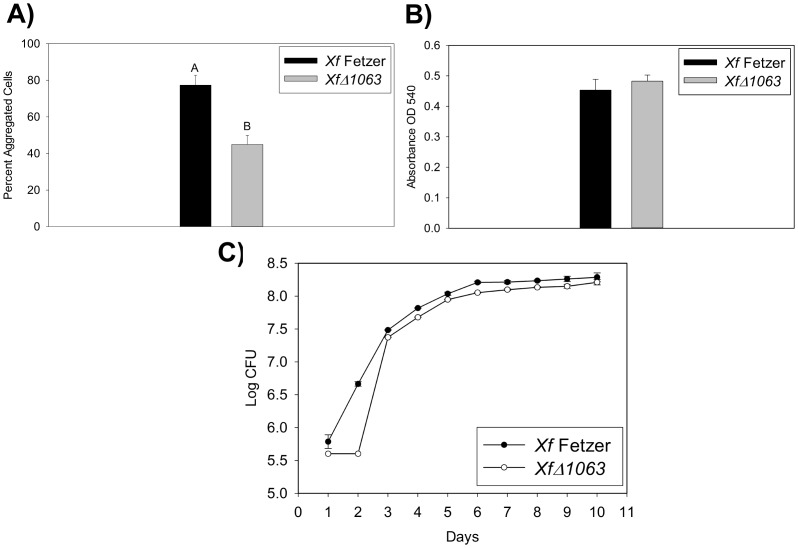
Evaluation of biofilm formation, cell aggregation and cell growth in XfΔ1063 mutants.A) Comparison of cell aggregation by wild-type Xf Fetzer, Xf Δ1063 mutant after 10 days growth in static liquid culture. Values shown are mean of 10 samples +/− standard error. The assay was repeated twice and data shown is representative of both assays. B) Comparison of biofilm formation by wild-type Xf Fetzer and Xf Δ1063 mutant after 10 days growth in static liquid culture. Values shown are mean of 10 samples +/− standard error. The assay was repeated twice and data shown is representative of both assays. C) Comparison of cell growth by wild-type Xf Fetzer and Xf Δ1063 mutant over 10 days growth in liquid culture with shaking at 100 rpm. Values shown are the mean of 10 samples +/− standard error. The assay was repeated twice and data shown is representative of both assays.